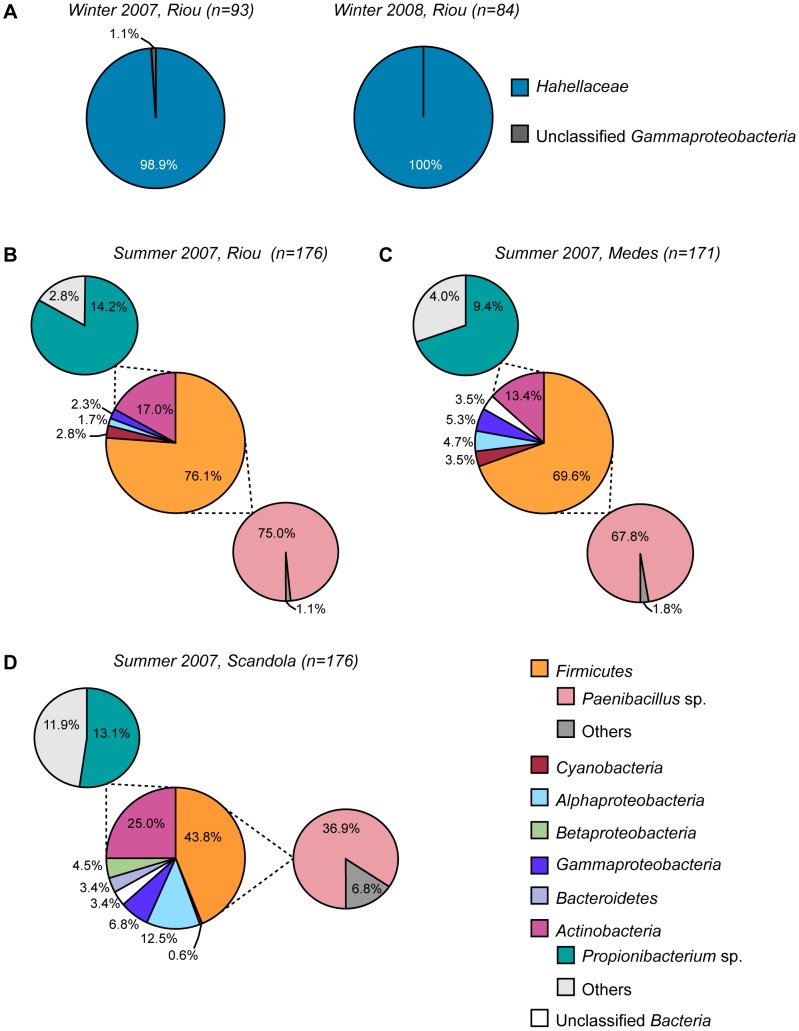
Bacterial diversity of clone libraries derived from P. clavata colonies.Pie charts illustrating the composition of bacterial communities in the winter 2007 and winter 2008 samples from Riou (A) and the summer 2007 samples from Riou (B), Medes (C) and Scandola (D). The large pies represent the clone library composition at the family level (A) and at the phyla or class levels (B–D). The smaller pies in B–D represent the affiliations of Actinobacteria and Firmicutes sequences at the genus level. The relative abundances of the bacterial groups retrieved from the libraries are indicated as percentages.